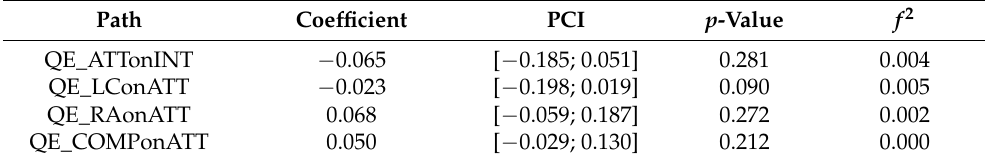
Table 3. Assessment of non-linear